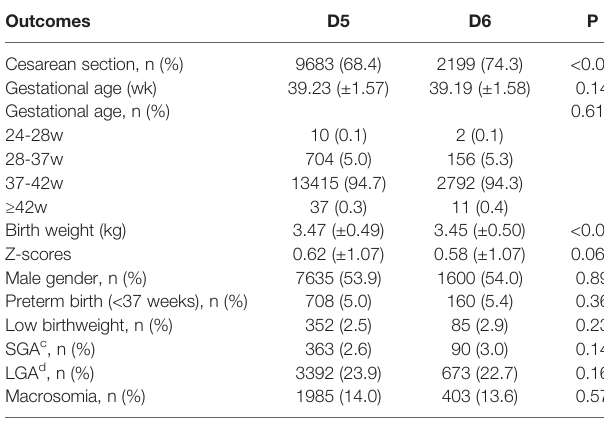
TABLE 2 | Neonatal outcomes transferred from blastocysts frozen at day 5 vs day